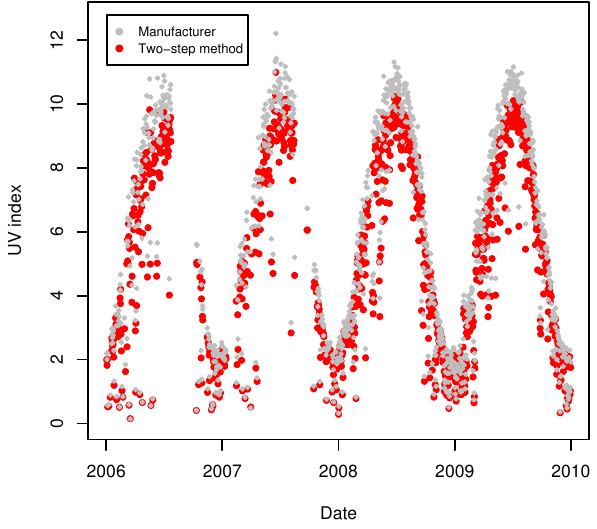
Fig. 6. Temporal evolution of the daily UVI at Granada during four years (2006–2009) using the two-steps calibration method and the manufacturer’s calibration